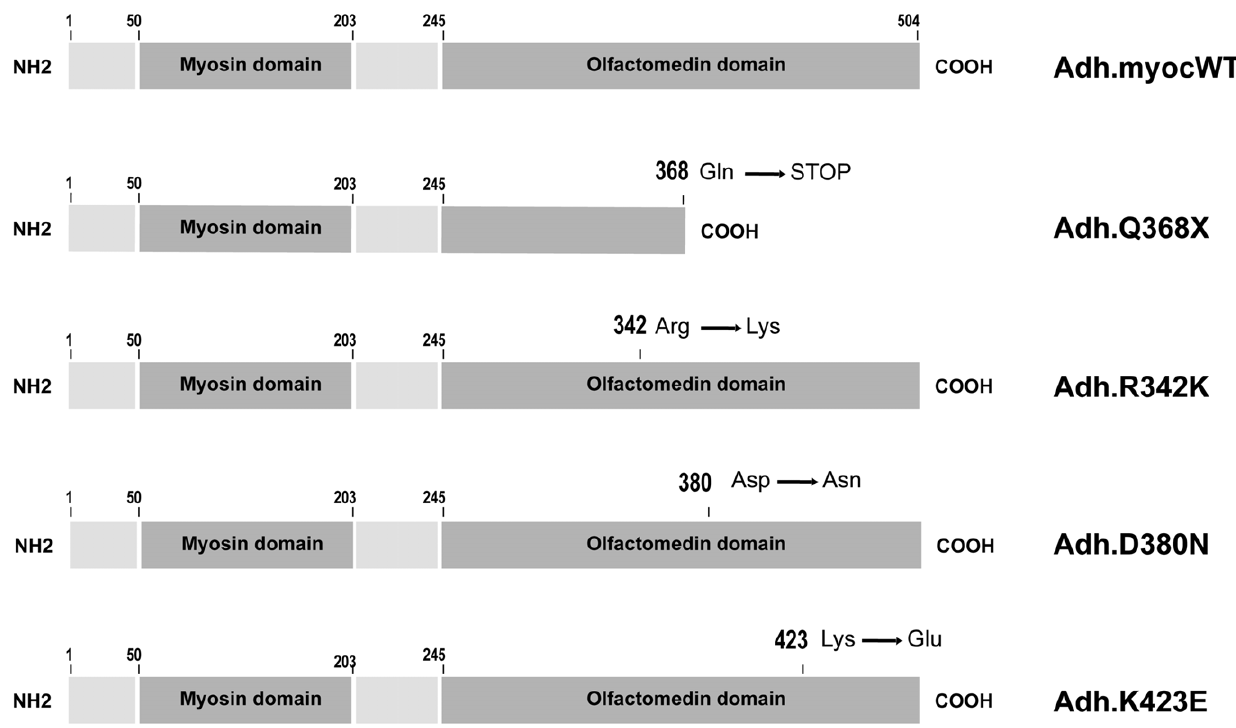
Figure 1. Schematic representation of MYOC wild-type and mutant proteins used for the adenoviral constructions. Myocilin protein contains a signal peptide cleavage (aa 1–50) and three folding domains. An N-terminal myosin domain (aa 50–203), a linker region (aa 203–245), and C-terminal olfactomedin domain (aa 245–504). All four selected mutants have mutations in the C-terminal olfaction domain. The Q368X mutation produces a truncated protein.